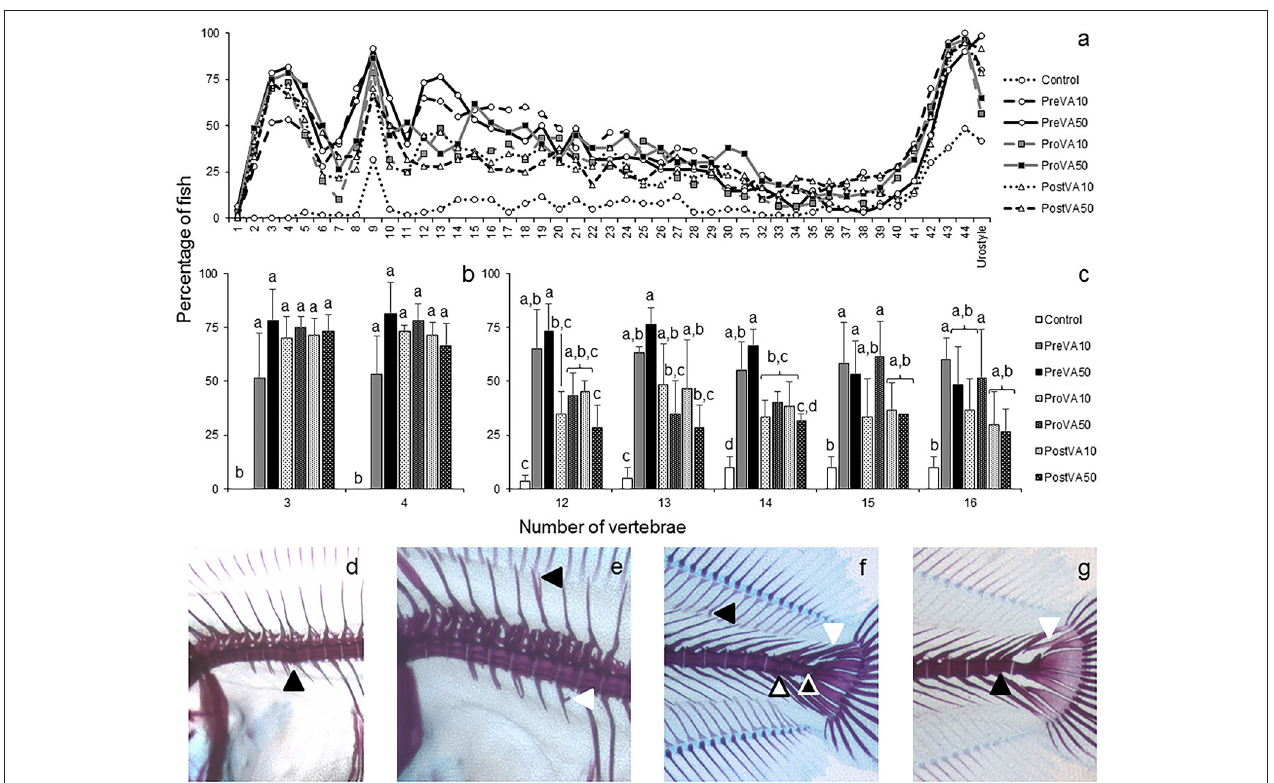
FIGURE 6 | Percentage of Senegalese sole juveniles with a deformity in axial skeleton at 55 dph when fed increased dietary vitamin A levels at different developmental stages. Percentage of juveniles showing a deformity at each vertebra (a) , detailed representation of this percentage (mean ± standard deviation) of fish with deformities at the 3rd and 4th vertebrae (b) , and at the 12, 13, 14, 15, and 16th vertebrae (c) . Detailed view of cephalic vertebrae compression (black arrowhead) (d) , miss-joint of neural spines (black arrowhead) and ectopic calcification in a parapophysis (white arrowhead) (e) , curved pterigophore (black arrowhead), neural spine-like at the urostyle (white arrowhead), fused preurals (white-filled arrowhead) and straight urostyle (black-filled arrowhead) (f) , extra neural spine in preural 1 (black arrowhead) and curved modified neural spine (white arrowhead) (g) , in fish at 55 dph. For a detailed description about the different experimental groups, please see the legend of Figure 1 . Different letters at the top of each bar denote statistically significant differences among experimental groups (ANOVA, P < 0.05; N =